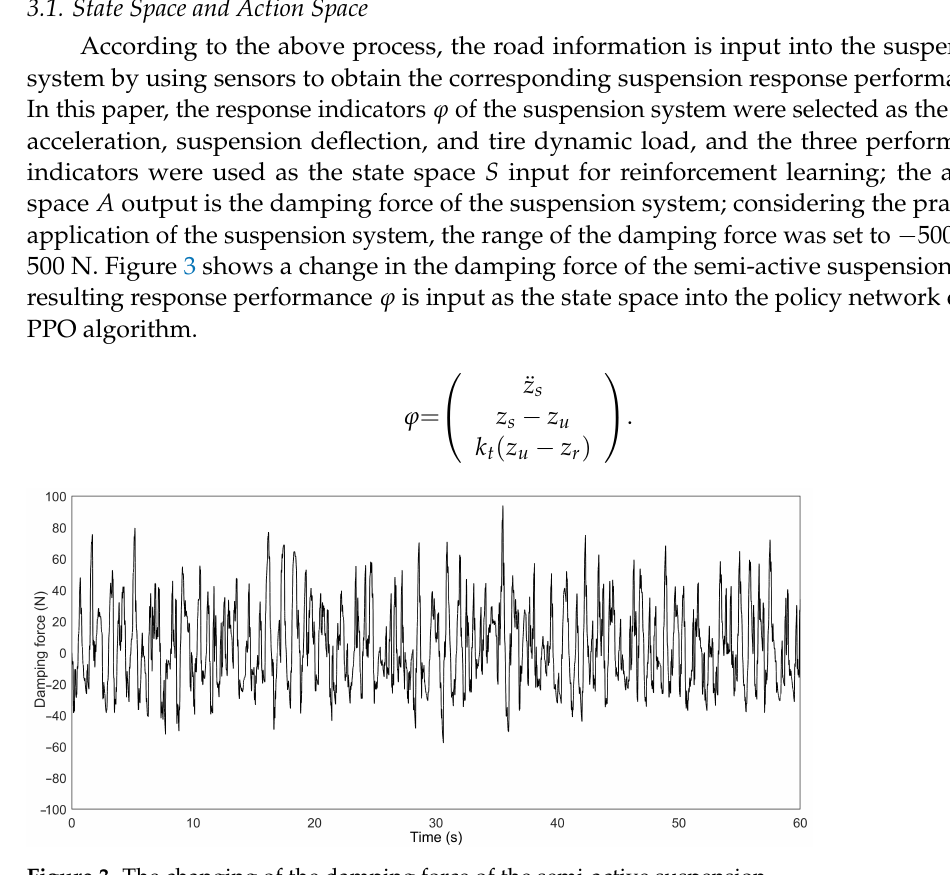
Figure 3. The changing of the damping force of the semi-active